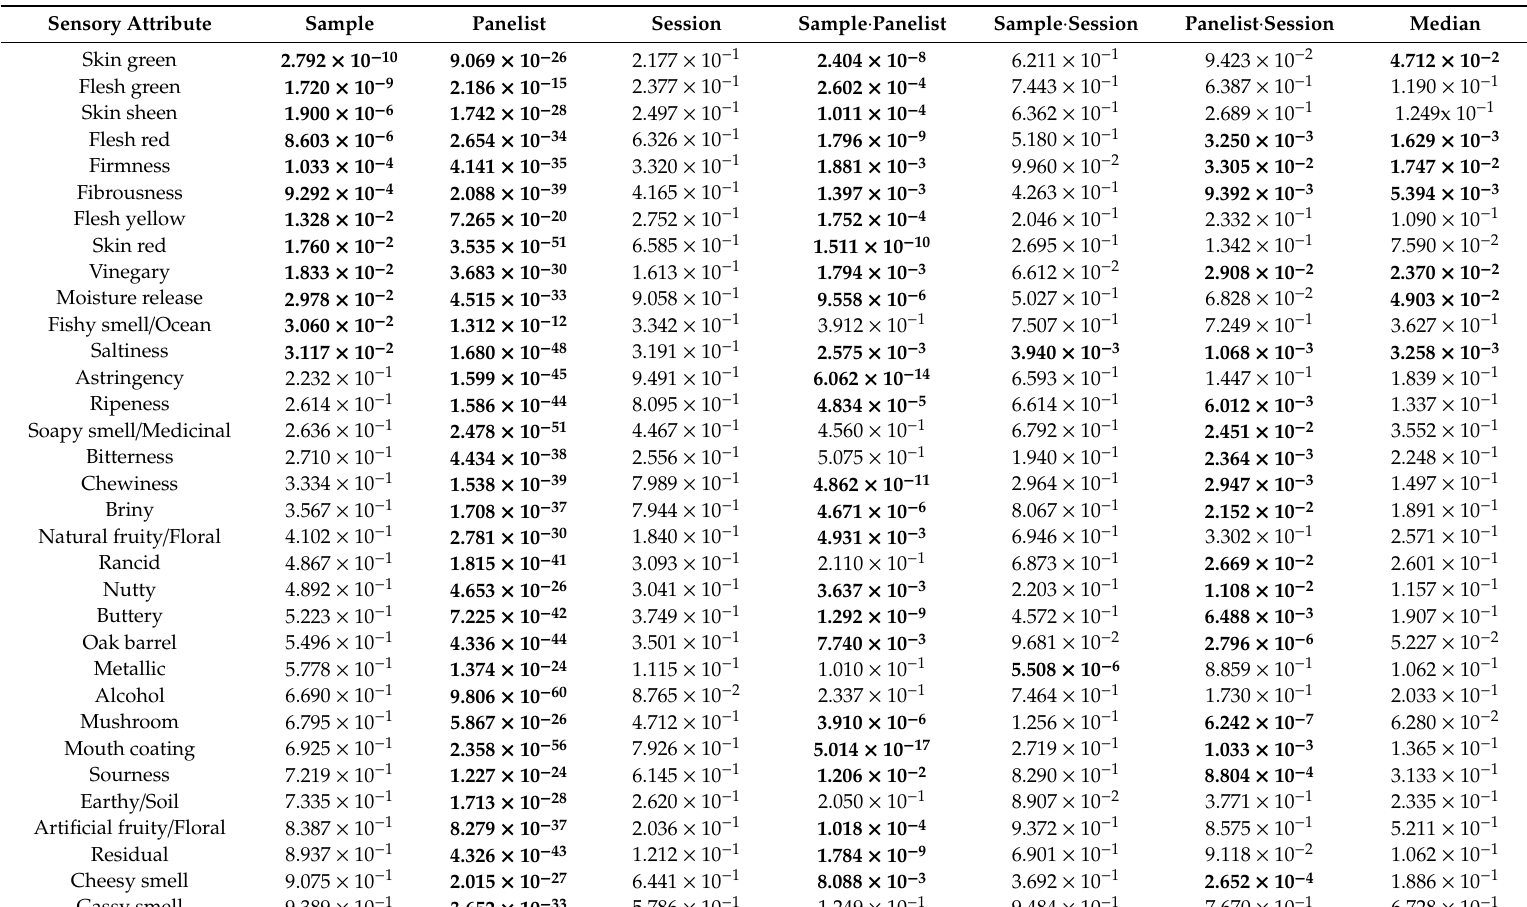
Table 1. Overall panel performance as assessed by analysis of variance (ANOVA) sorted by sample p -values, including main e ff ects, and interactions. Panelist, session, and their interactions were considered as random, while the sample was studied as fixed factor /